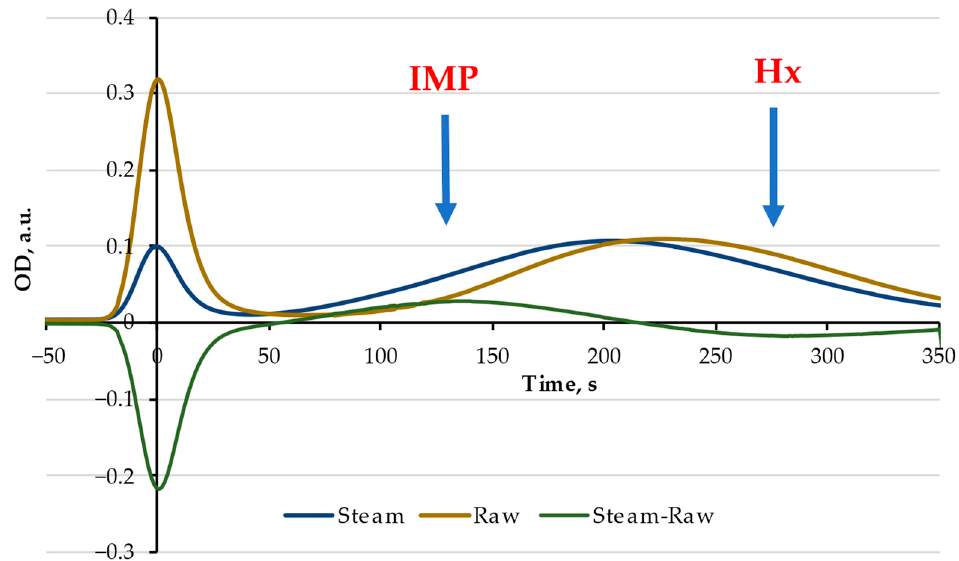
Figure 8. Chromatograms of Alaska Pollock samples before (Raw) and after (Steam) cooking at 100 ◦ C for 60 min, and difference of the two chromatograms (Steam–Raw).